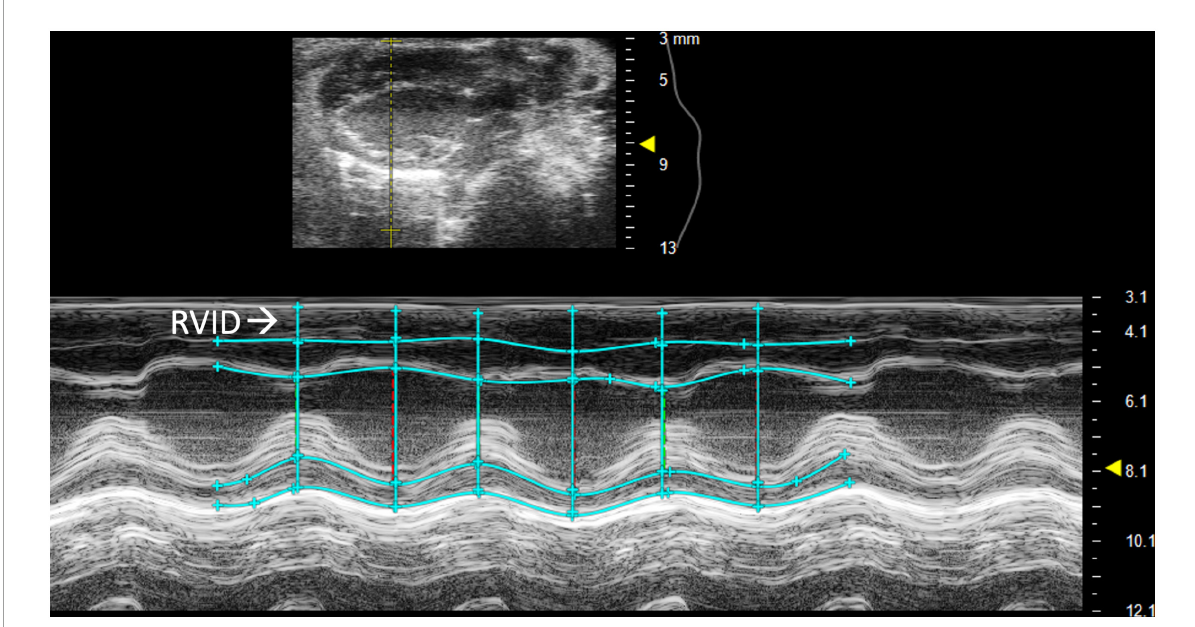
FIGURE2 Right ventricular internal diameter (RVID), a measurement of the right ventricle during systole and diastole, is obtained by analyzing parasternal long axis (PLAX) view images in M-mode.